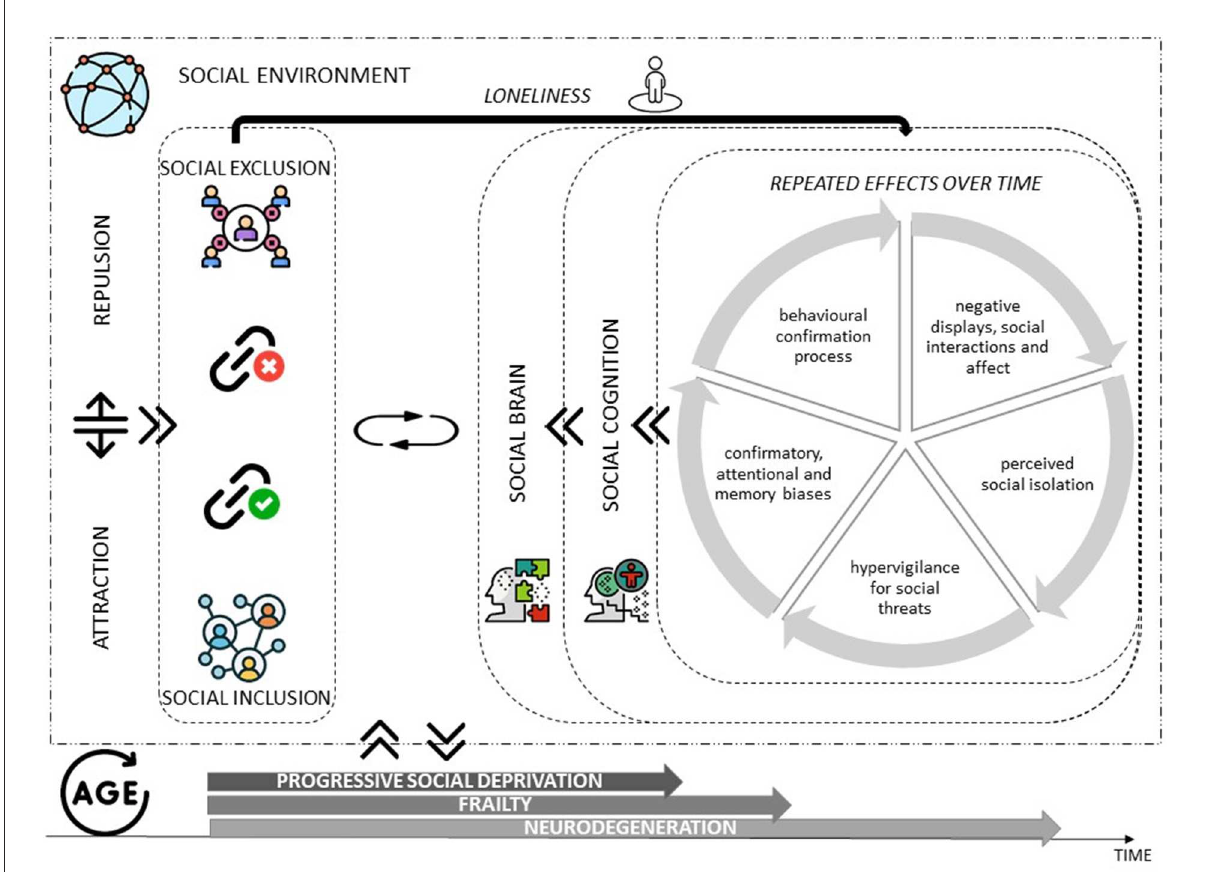
FIGURE1 Theoretical model summarizing the relationships that exist between the dimensions of interest, the interactions between the individual and the social environment, and the dynamics of mutual interchange that affect the social cognition and social brain along the passage of time and the increasing age of the